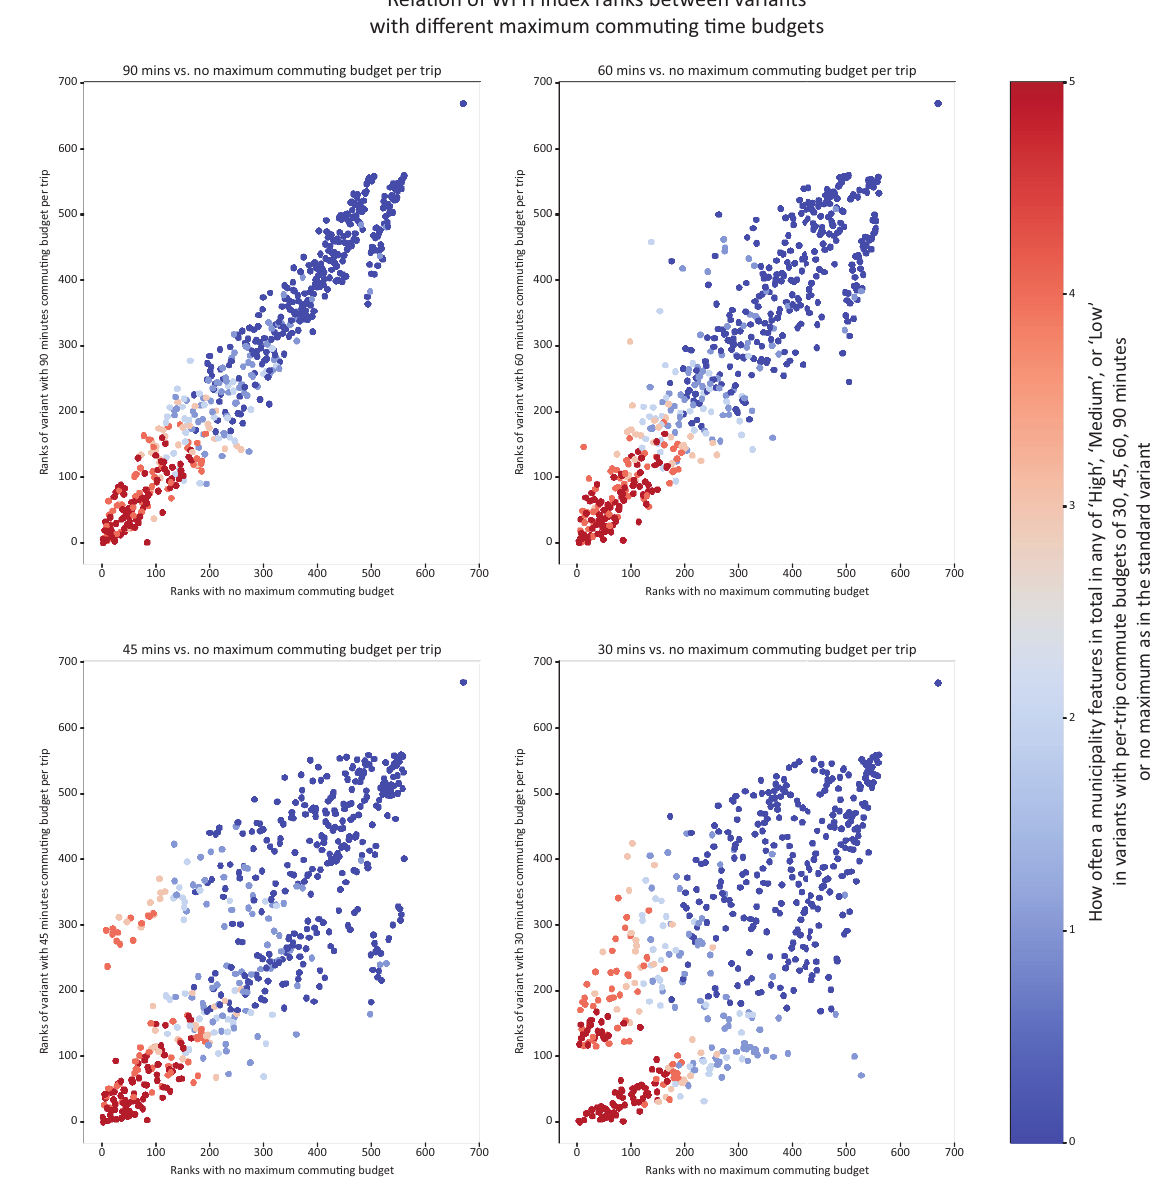
Figure 10. Comparison of rank correlations between WFH index variants with different commuting trip thresholds. 2020). Particularly recognisable is the potential in